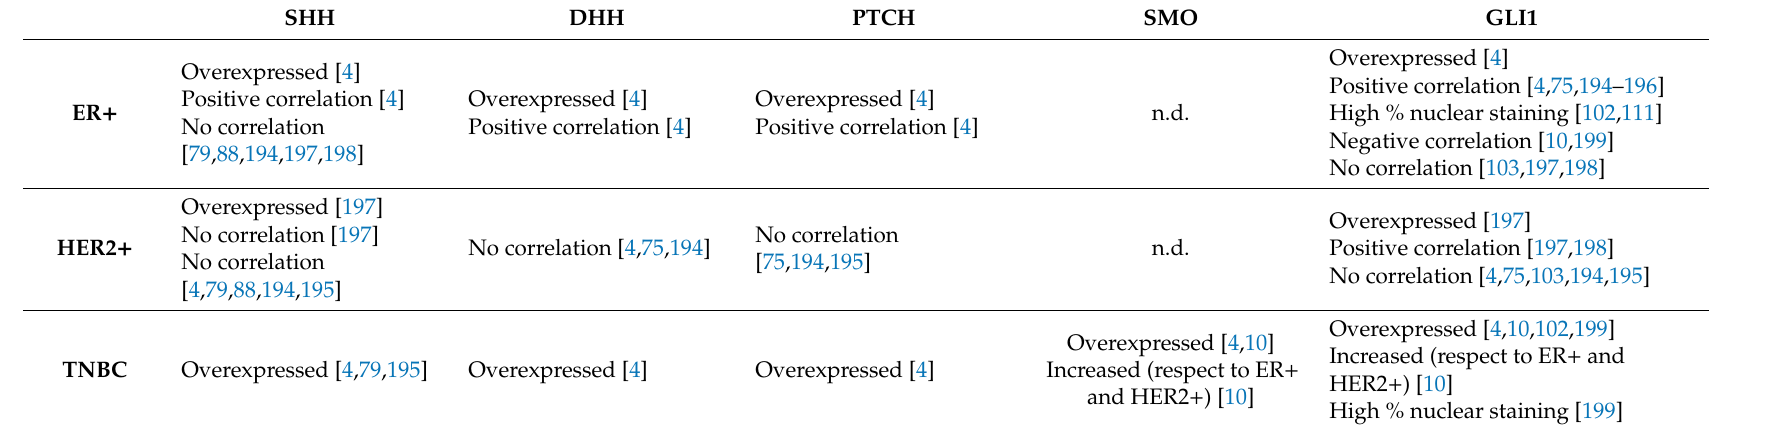
Table 1. Association of members of the Hh pathway with BC